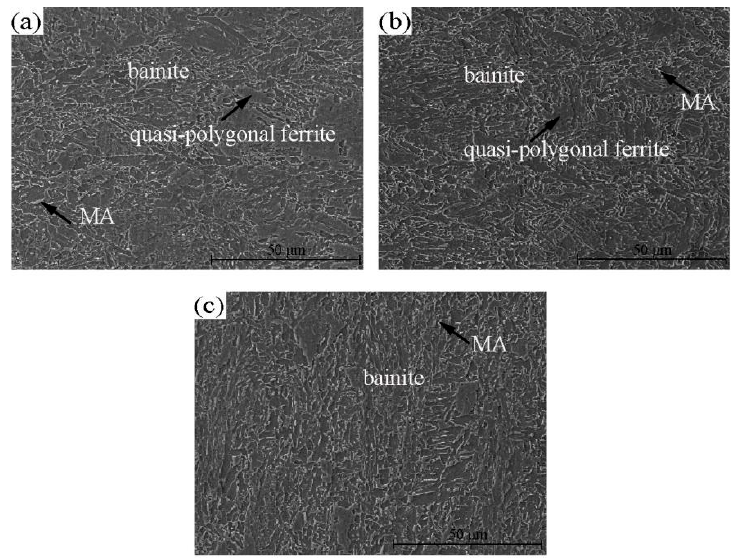
Figure 5. Microstructures of the samples at different coiling temperatures: ( a ) 500 °C, ( b ) 400 °C and ( c ) 300 °C.